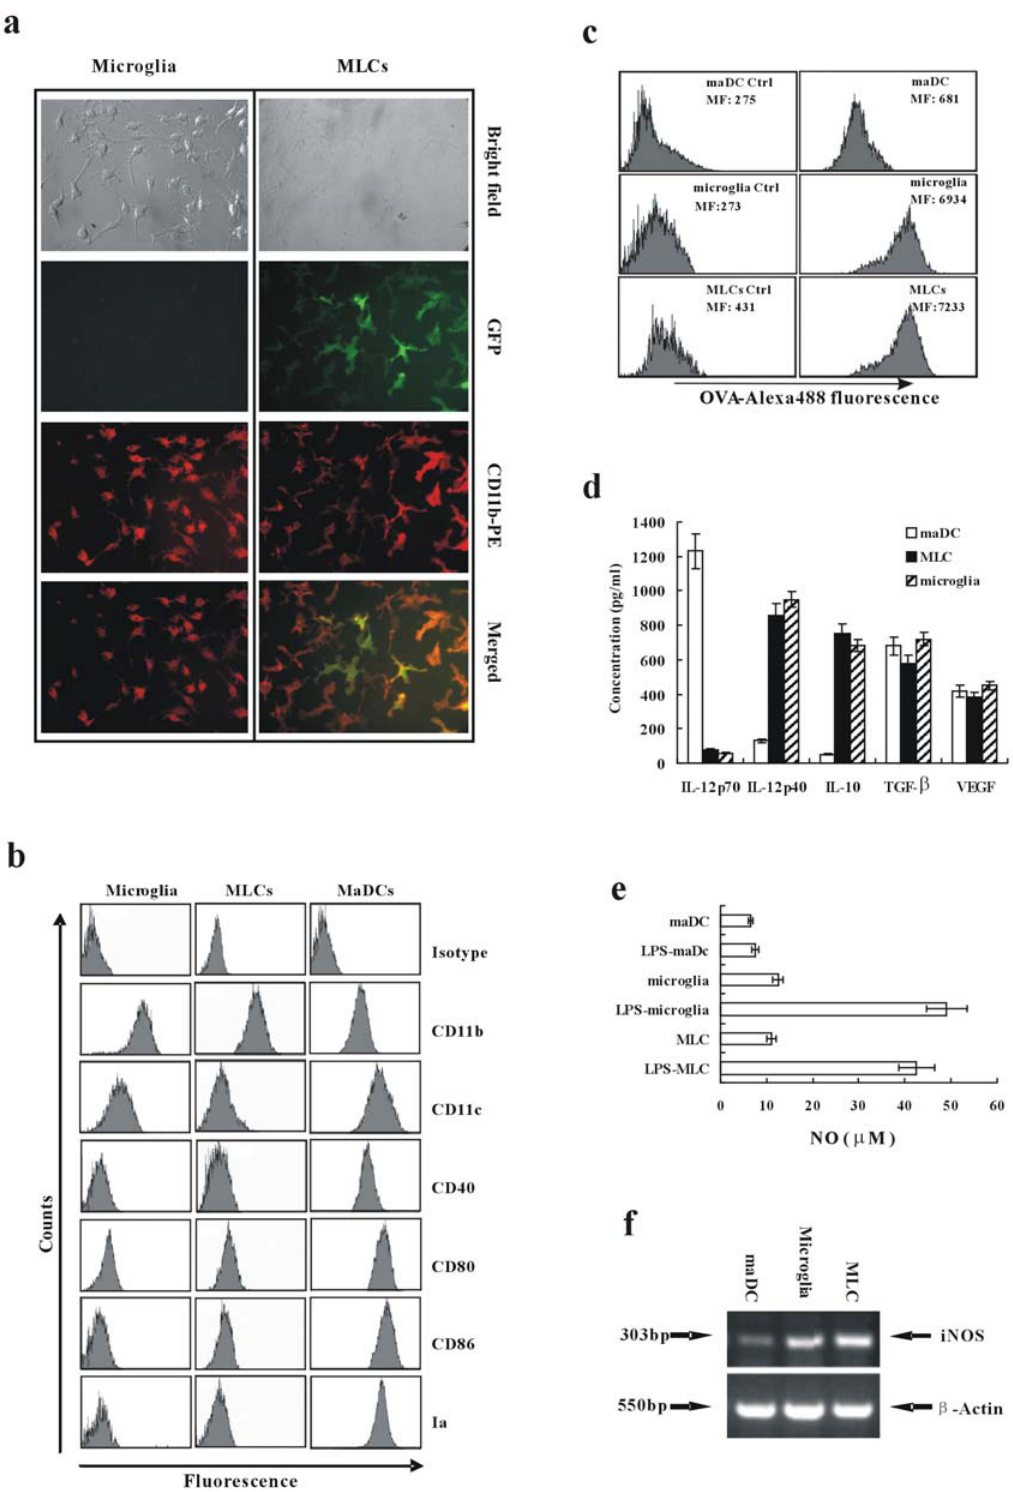
Figure 3. Endothelia induce maDCs to differentiate into MLCs. (a) GFP + maDCs cultured on monolayers of CNS endothelia for 14 days and were labeled with PE-conjugated anti-CD11b antibody. Fluorescence photos were taken with a Leica fluorescent microscope (objective 40 6 ). (b) Comparison of phenotype among microglia, MLCs and maDCs. (c) Comparison of phagocytic ability among microglia, MLCs and maDCs. Numbers in histograms indicate the geometric mean fluorescence. (d) The secretion of IL-12p70, IL-12p40, IL-10, TGF- b 1 and VEGF by maDC, microglia and MLCs stimulated by 10 ng/ml LPS for 24 h was detected. (e) The production of NO by maDC, microglia and MLCs stimulated by 10 ng/ml LPS for 24 h was detected. (f) The expression of iNOS in maDC, microglia and MLCs was detected by RT-PCR.